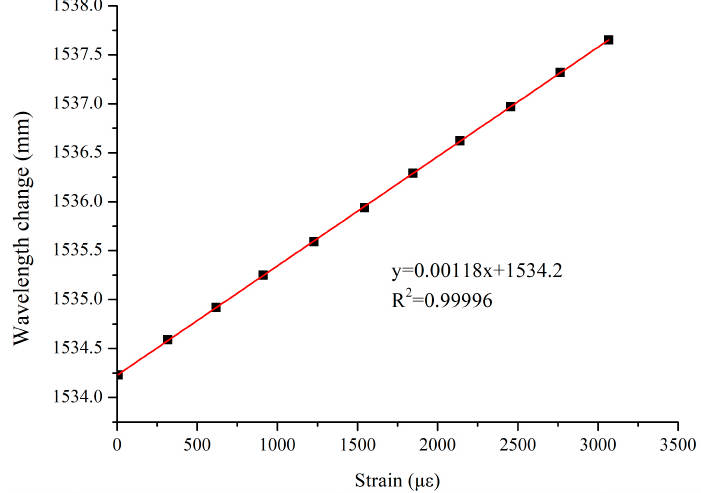
Figure 4. Calibration of bare gratings.